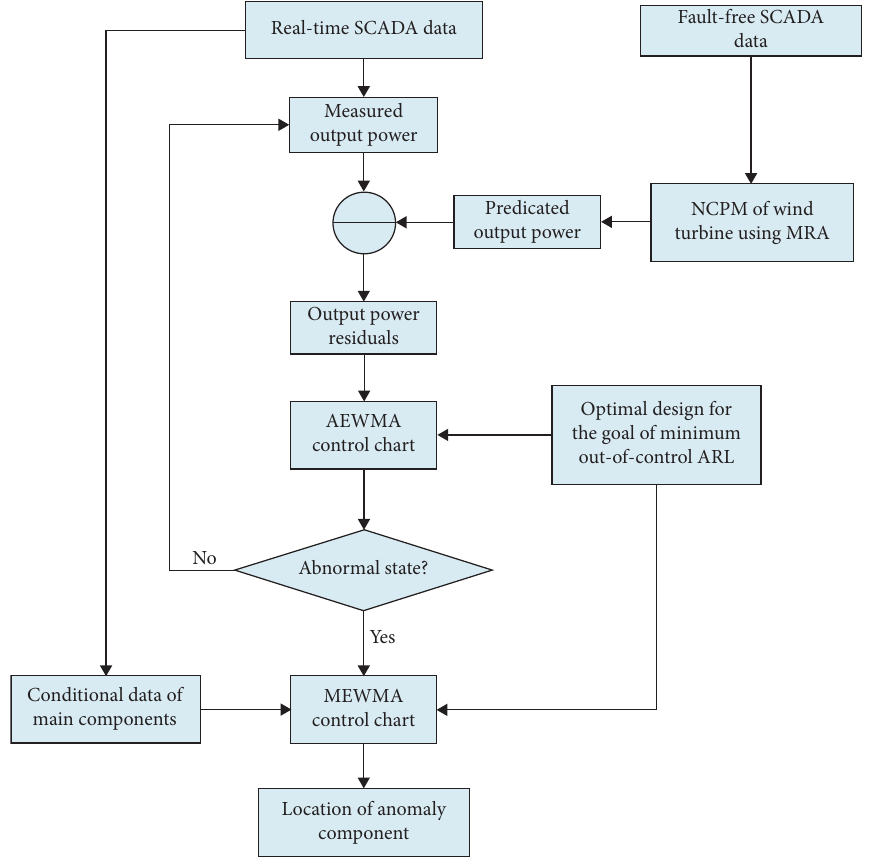
Figure 4: Flowchart for the wind turbine CM system based on AMCCs. Table 3: Anomaly information for the wind turbine unit during the period from 12/1/2015 to 6/1/2016.